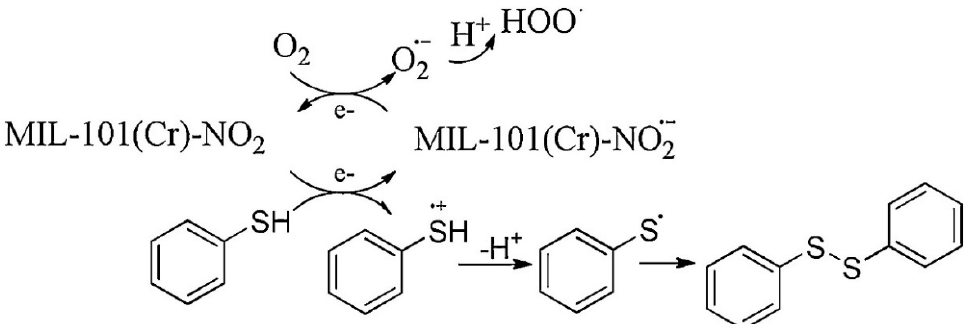
Figure 5. Proposed pathway for the aerobic oxidation of thiophenol to benzene disulphide using MIL-101(Cr)-NO 2 as catalyst [78].